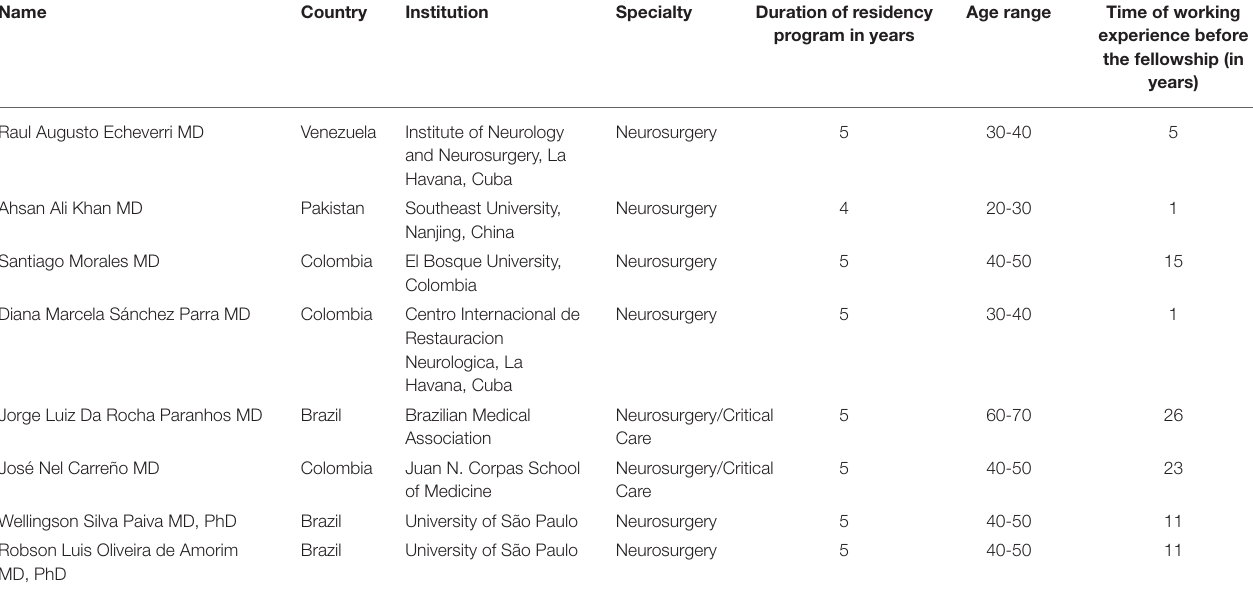
TABLE 2 | Characteristics of past and current